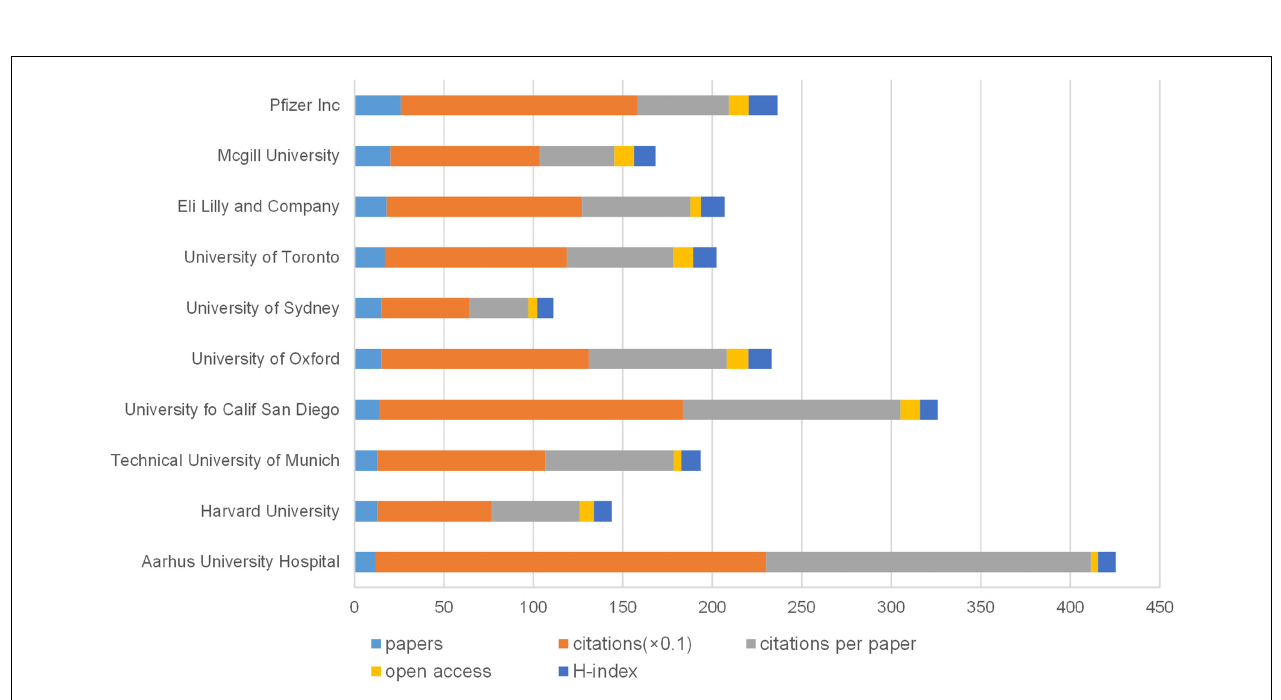
Frontiers in Human Neuroscience |